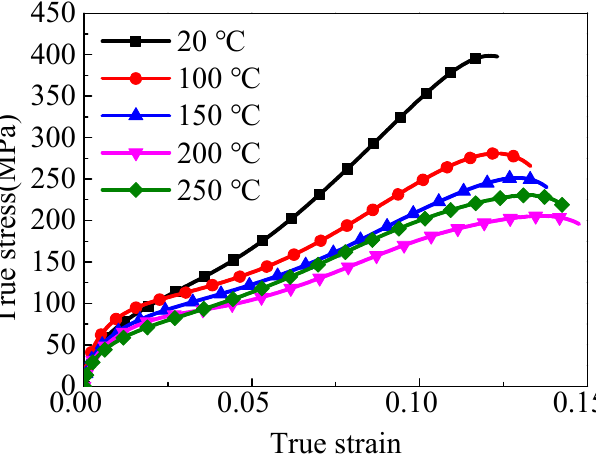
Figure 2. Stress–strain curves at different temperatures under 1000 s − 1 . The dynamic mechanics response of the wrought AZ31 ‐ TD alloy at room tempera ‐ ture is obviously highly anisotropic, which is shown by the sigmoidal curve. As the direc ‐ tion of impact loading is perpendicular to the normal direction of (cid:4668)0002(cid:4669) texture plan, it is easier for a large number of (cid:4668)101(cid:3364)2(cid:4669) tension twinning to be activated, leading to the typical characteristic curve presence [29]. With the temperature increased, the critical strain, corresponding to the peak stress, gradually increases from 0.12 to 0.14. The peak stress decreases from 398.61 to 204.16 MPa with temperature increased. Finally, the evo ‐ lution trend of stress–strain curves are from a sigmoidal curve to a concave ‐ down curve. It is illustrated that the thermal softening has large effect on the wrought AZ31 ‐ TD dy ‐ namic deformation behavior. This phenomenon is caused by the reduced critical resolved shear stress (CRSS) of the non ‐ basal slip and more activation of the non ‐ basal glide sys ‐ tems, which is similarly reported by Liu et al. [21].